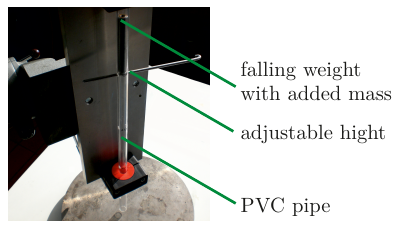
Figure 2. Tool drop setup.